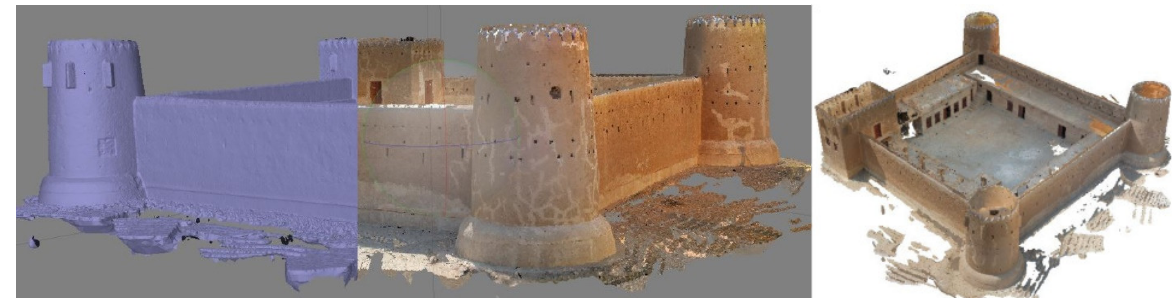
Figure 11: 3D model of the Al Zubarah fortress generated with Agisoft PhotoScan 1.0.4